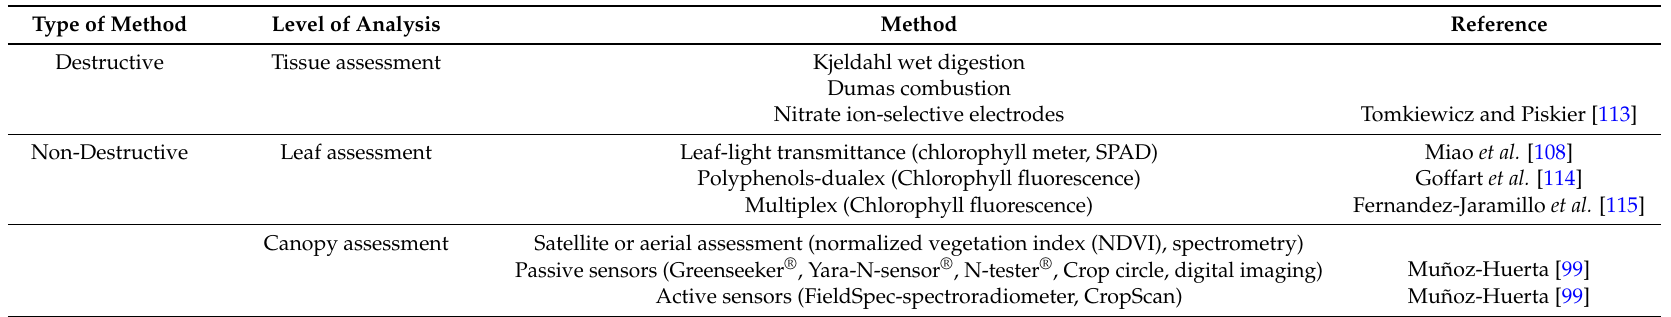
Table 5. Methods to assess N status of crops during